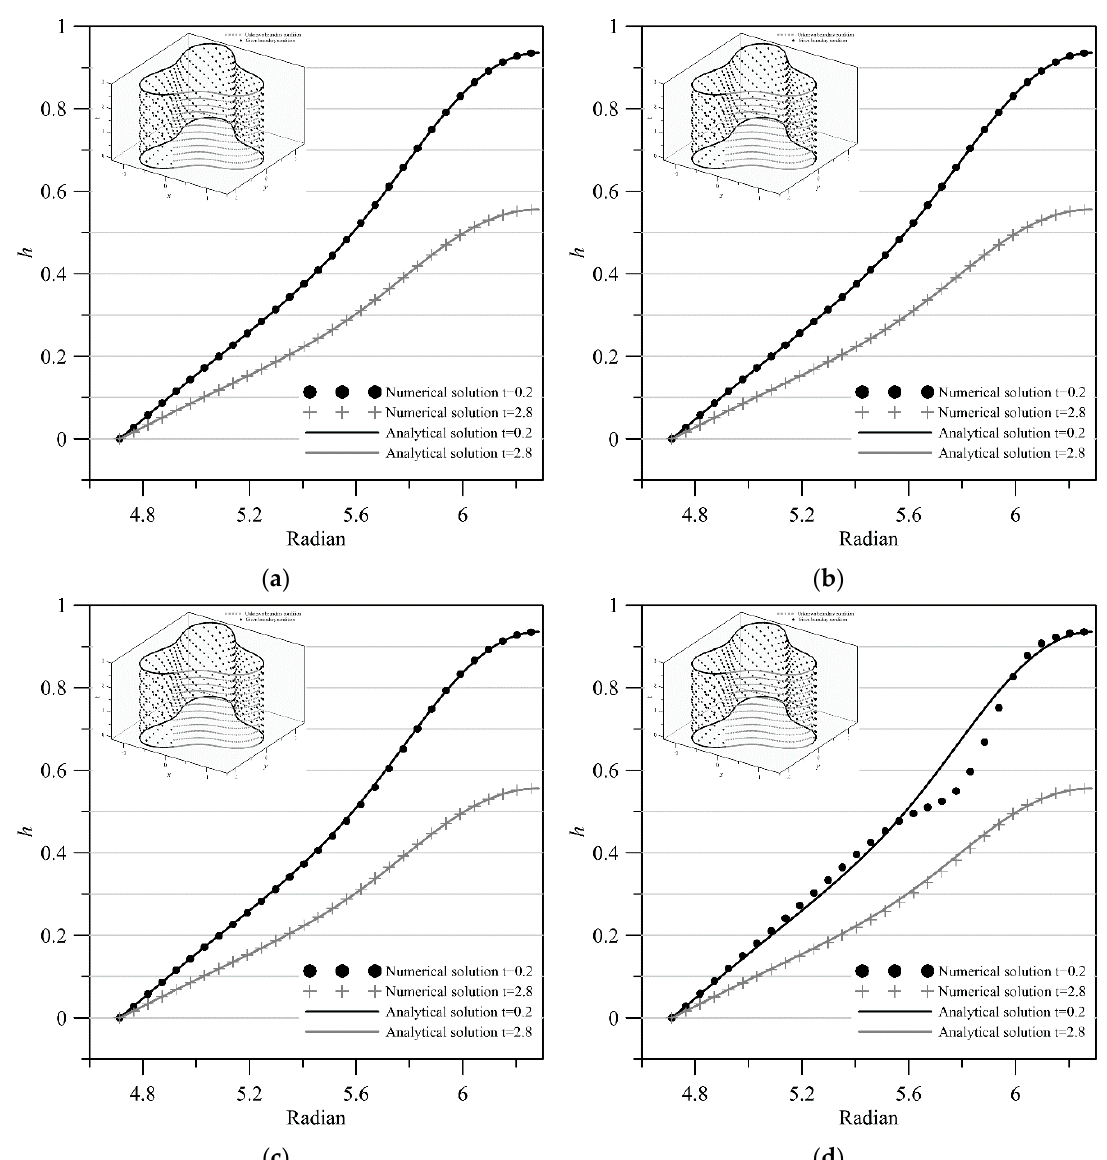
Figure 4. The computed results: ( a ) s = 0; ( b ) s = 0.001; ( c ) s = 0.01; ( d ) s = 0.1.